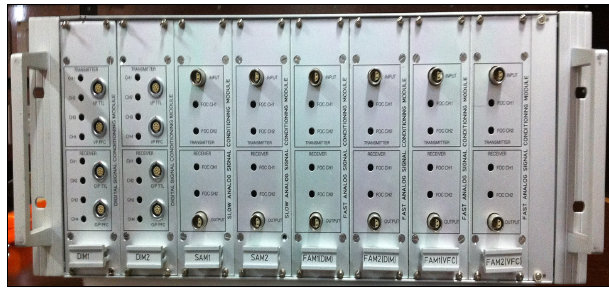
Fig. 10 : Prototype industrial Grade SCU (Fiber Optic